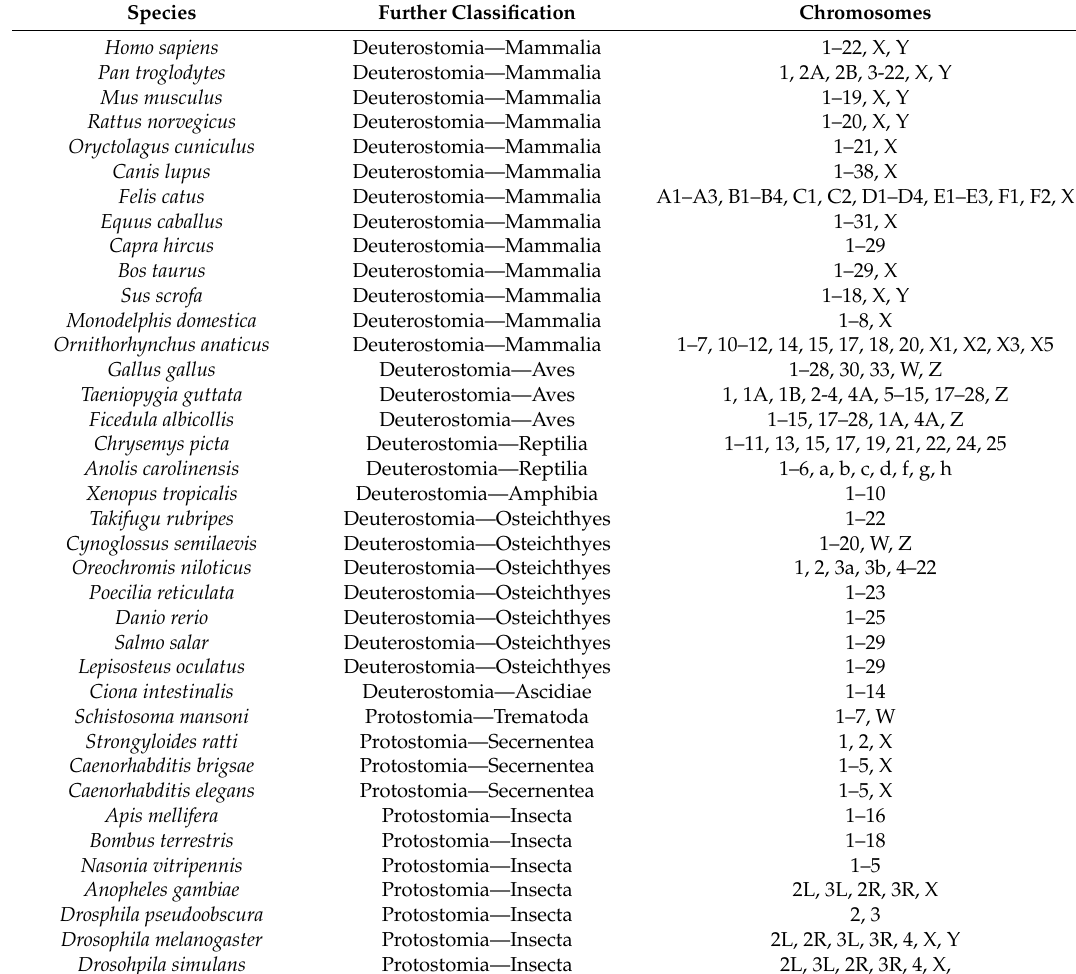
Table 1. Organisms and chromosomes used in our analysis (accession numbers of sequences are found within the appendix, Table